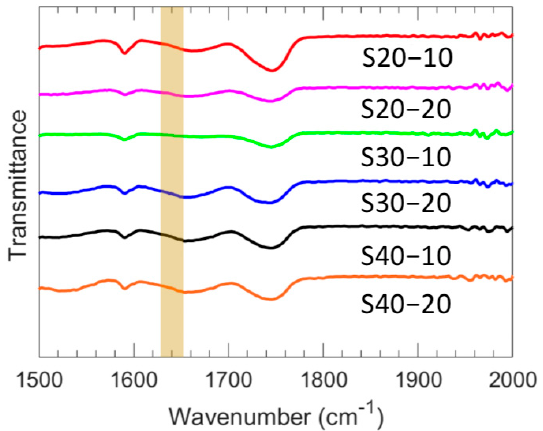
Figure 2. Representative FTIR spectra for each membrane composition.